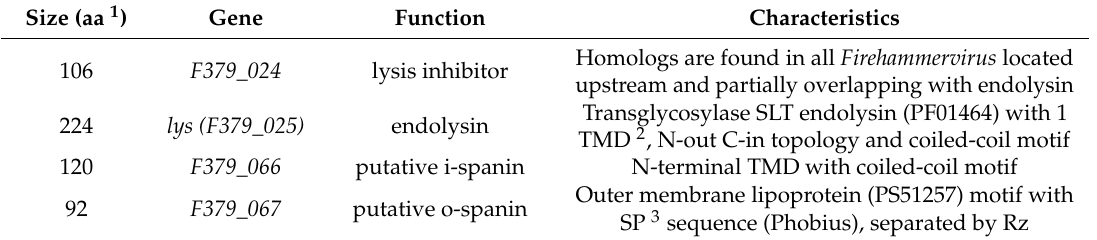
Table 2. Lytic genes predicted in Firehammervirus phage